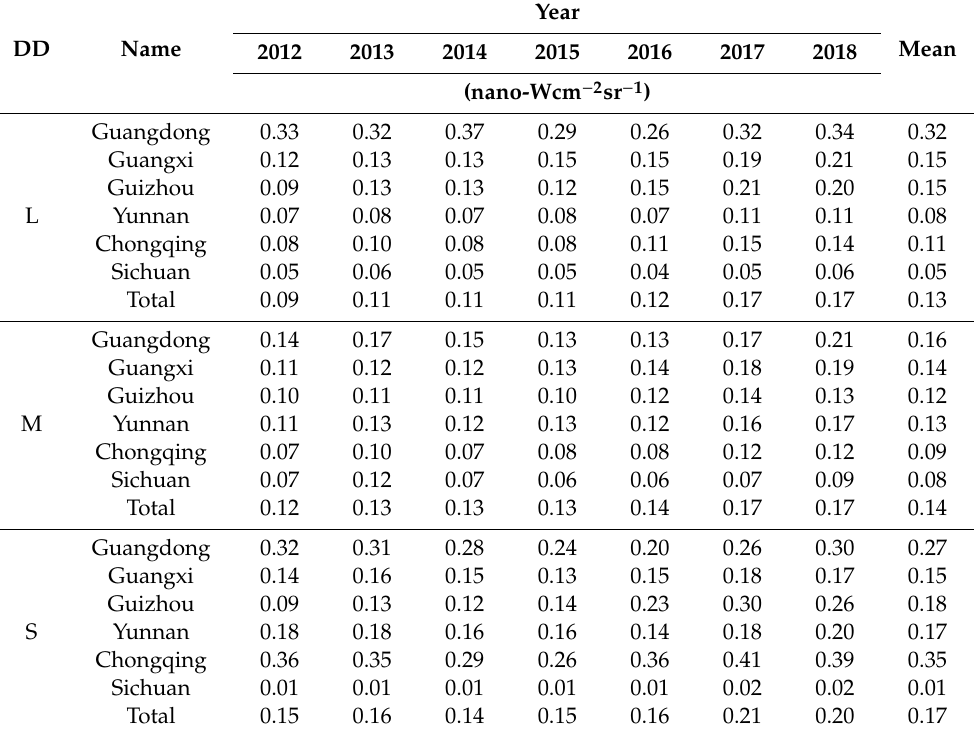
Table 2. The nighttime light intensity related to karst rocky desertification in southern China.